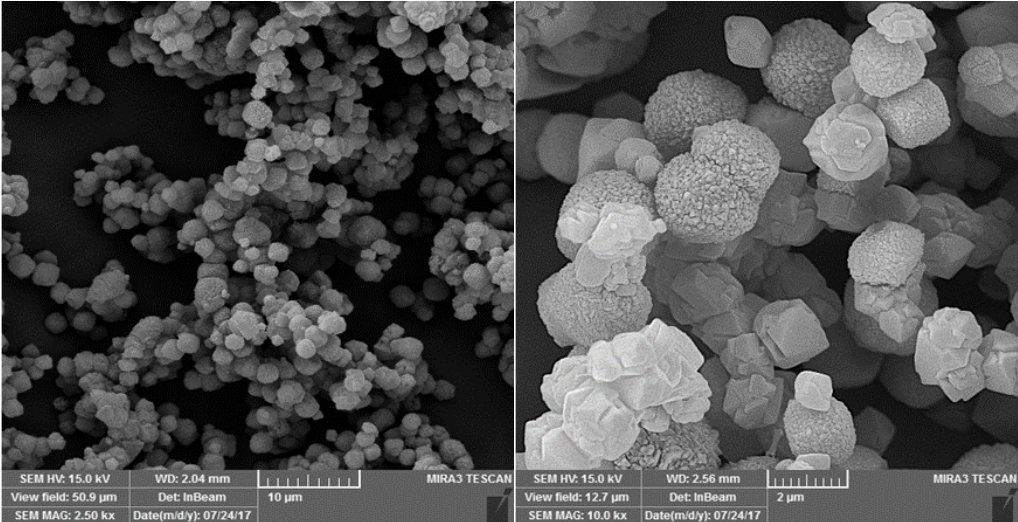
Fig. 1. a represent scanning electron microscope (SEM) images of